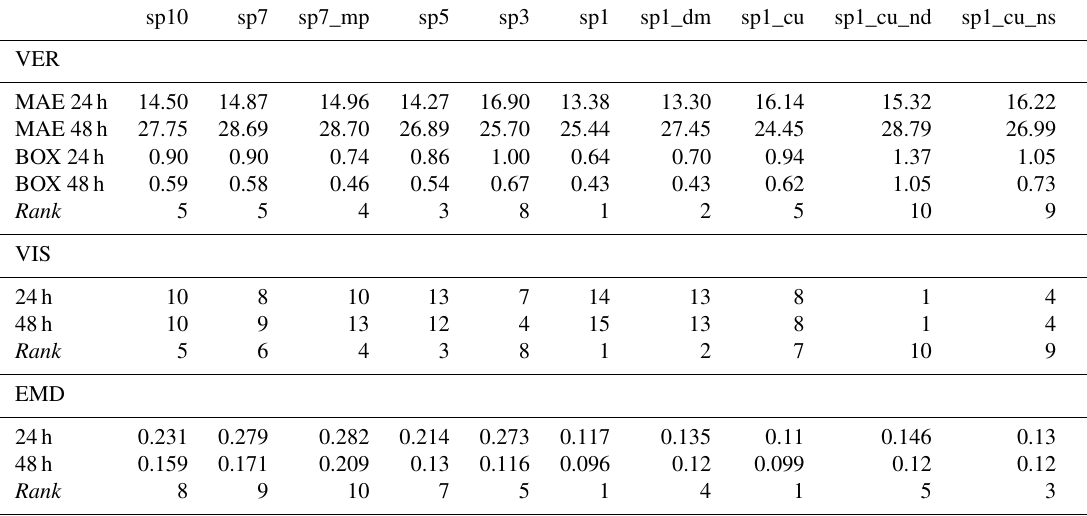
Table 2. Evaluation of WRF setups for dynamical downscaling ∗